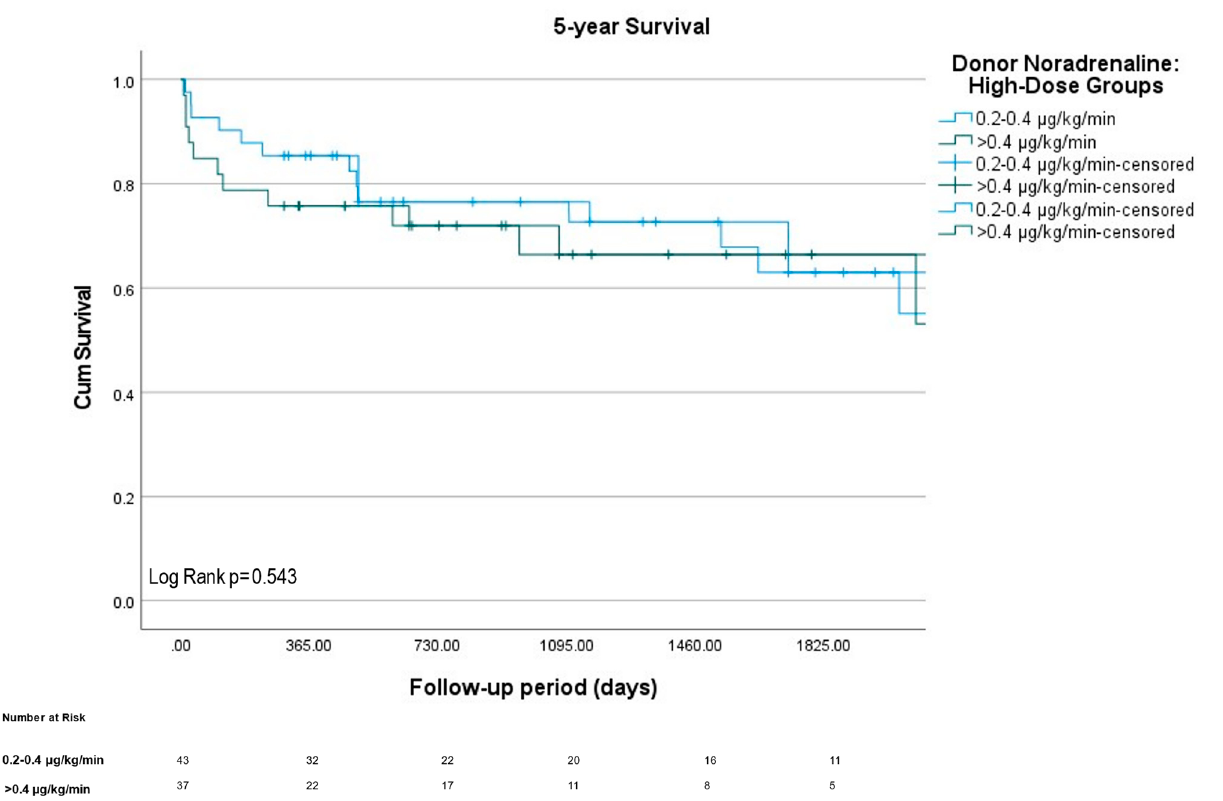
Figure 2. High-dose noradrenaline support subgroup analysis regarding survival. Kaplan-Meier survivals of subgroup analysis between high (0.2–0.4 μ g/kg/min, n = 43) and exceptionally high (>0.4 μ g/kg/min, n = 37) donor noradrenaline support prior to heart transplantation. Data under the graph representing patients at risk at specific time points in all groups.